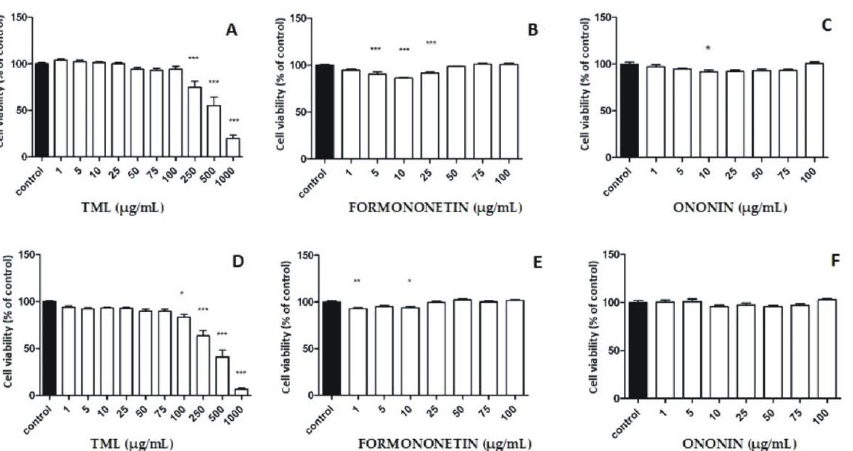
Figure 6. Effect of isoflavone reference substances and TML on the viability of MCF-7 human breast cancer cells after 24 h ( A – C ) and 48 h ( D – F ) incubation; results expressed as percentage of relative viability of treated cells compared to control. Values in graphs shown as mean ( n = 3) ± SD. Statistical differences * p < 0.05, ** p < 0.01, *** p < 0.001 for control versus cell lines incubated with TML or a